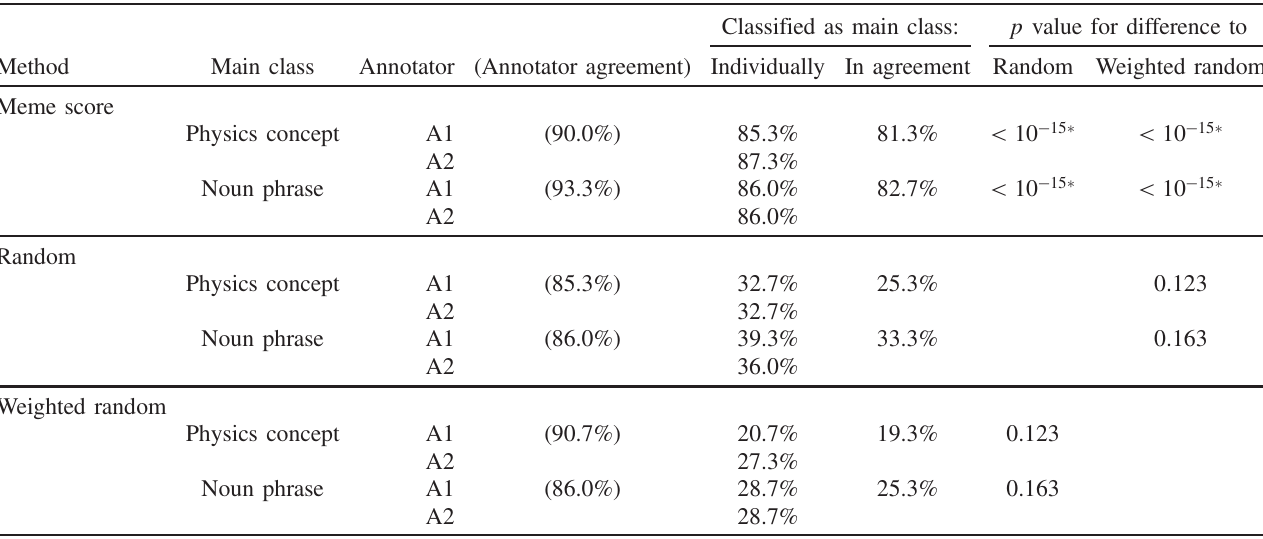
TABLE II. The two annotators (A1 and A2) classified more than 80% of the memes with the highest meme scores as relevant physics concepts and noun phrases. The differences involving the meme score are highly significant ( (cid:2) ). See Sec. IVand Supplemental Material [32] for